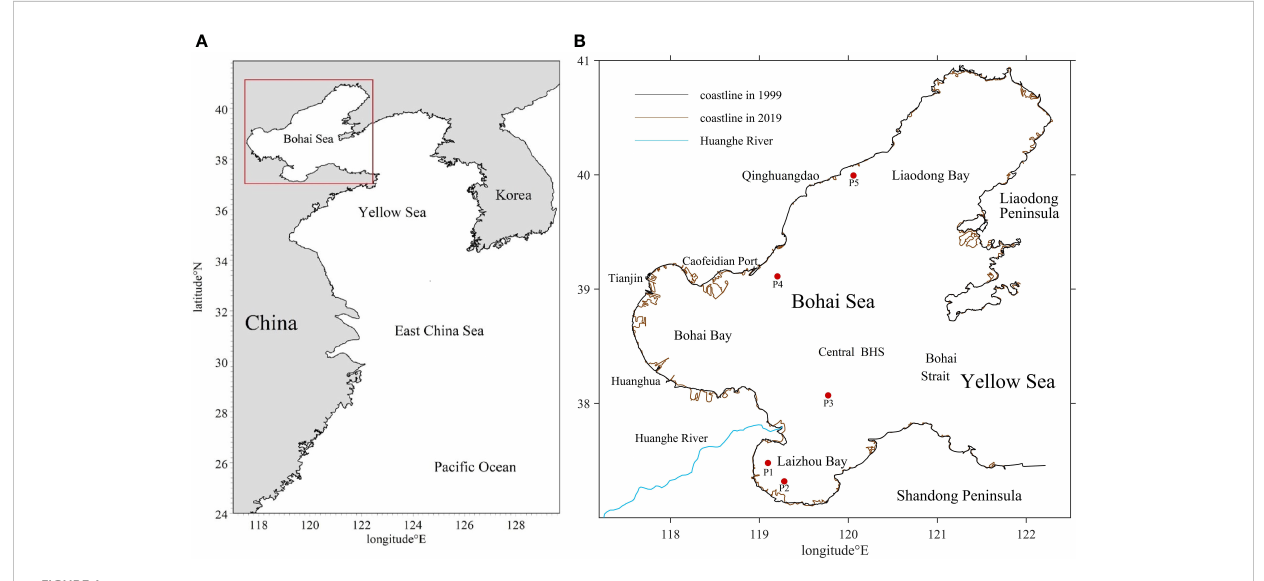
FIGURE 1 (A) Location of Bohai Sea; (B) Coastline in 1999 and